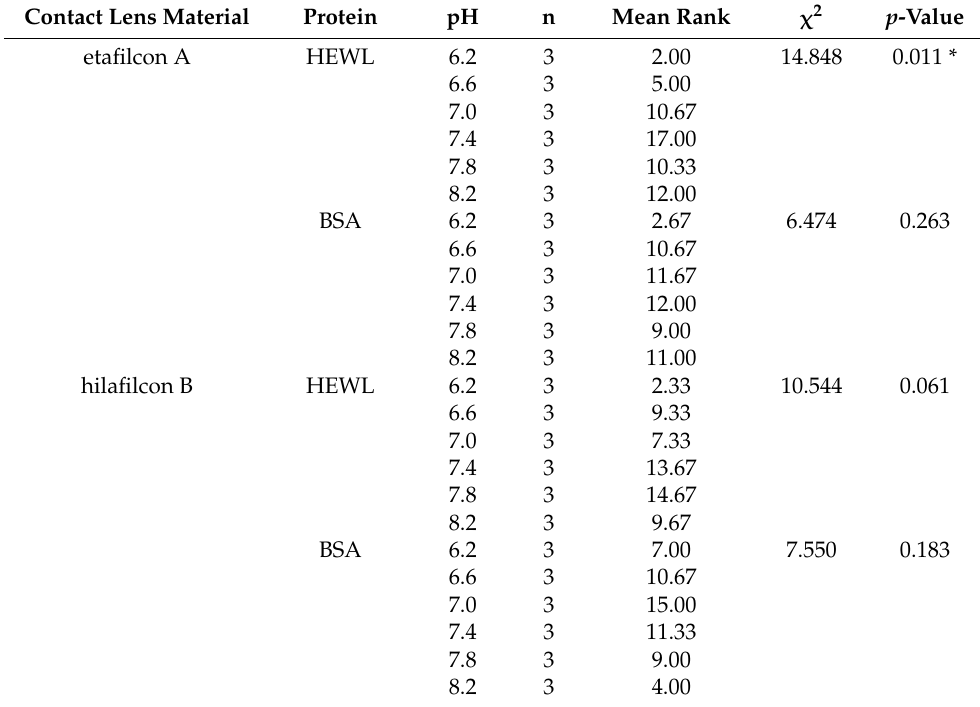
Table 2. The results of statistical analysis on the amount of deposited HWEL and BSA on etafilcon A and hilafilcon B depend on the pH. A repeated measures Kruskal–Wallis test was used for statistical analysis; * p < 0.05.